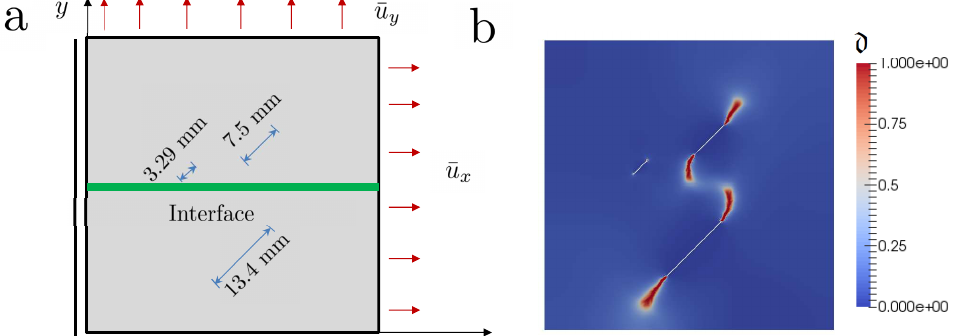
Figure 16. ( a ) Specimen with 3 inclined flaws and a horizontal joint. ( b ) Phase field damage pattern at the end of the